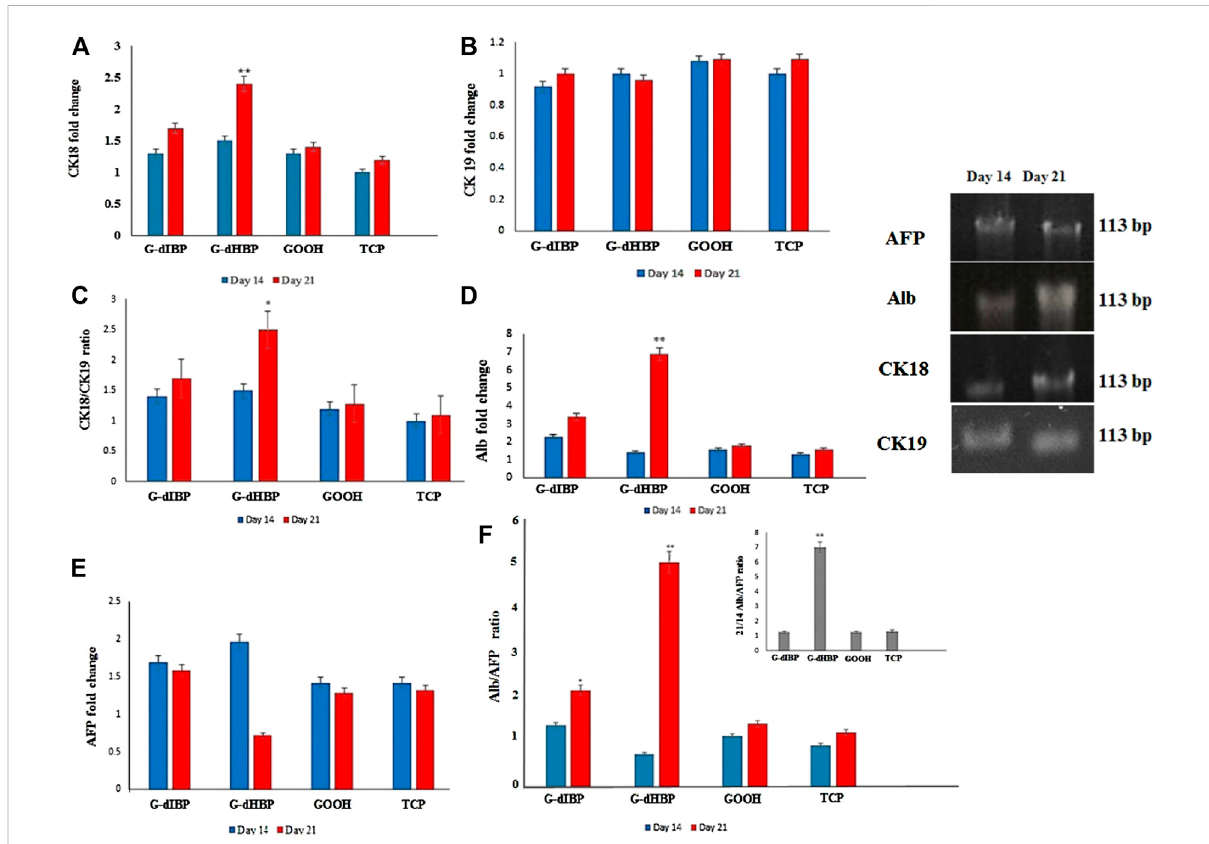
FIGURE 4 qRT-PCR of (A) CK18, (B) CK19, (C) CK18/CK19, (D) Alb, (E) AFP, and (F) Alb/AFP expression in different groups at 14 and 21 days after